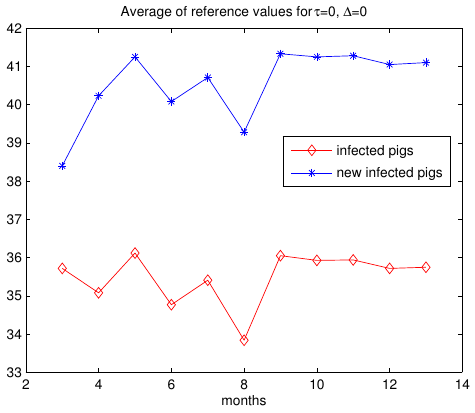
Fig. 13 Reference values in case of bad implementation of the vaccine for no external contamination rate and biohazards, τ = 0, ∆ = 0, with an average value of 35 . 48%.